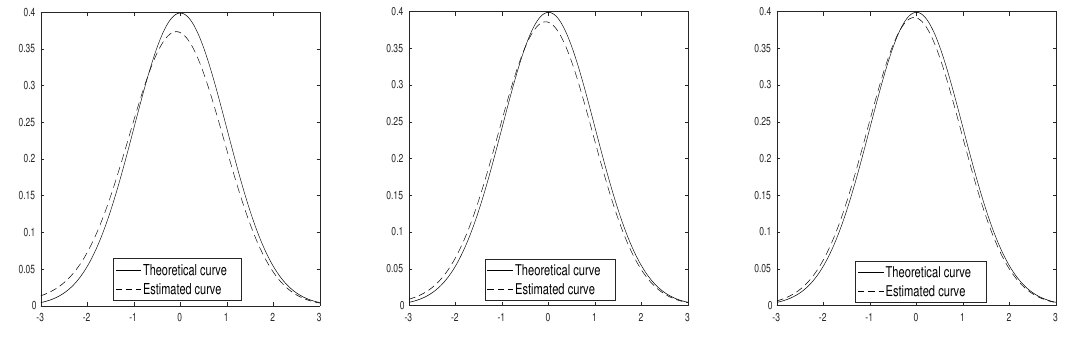
Figure 4: CR ≈ 48% and ( ρ 1 , ρ 2 ) = (0.3, 0.3) for n = 50, 200 and 400 respectively.